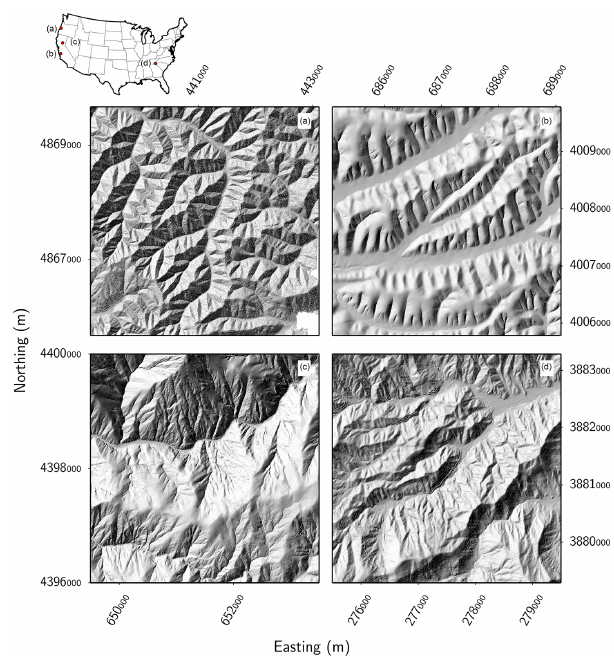
Figure 1. Map of the locations of each field site within the con- tinental USA with a shaded relief map of characteristic sections of each location’s topography. All coordinates are in UTM. (a) Oregon Coast Range, Oregon, UTM Zone 10N. (b) Gabilan Mesa, Califor- nia, UTM Zone 10N. (c) Northern Sierra Nevada, California, UTM Zone 10N. (d) Coweeta, North Carolina, UTM Zone